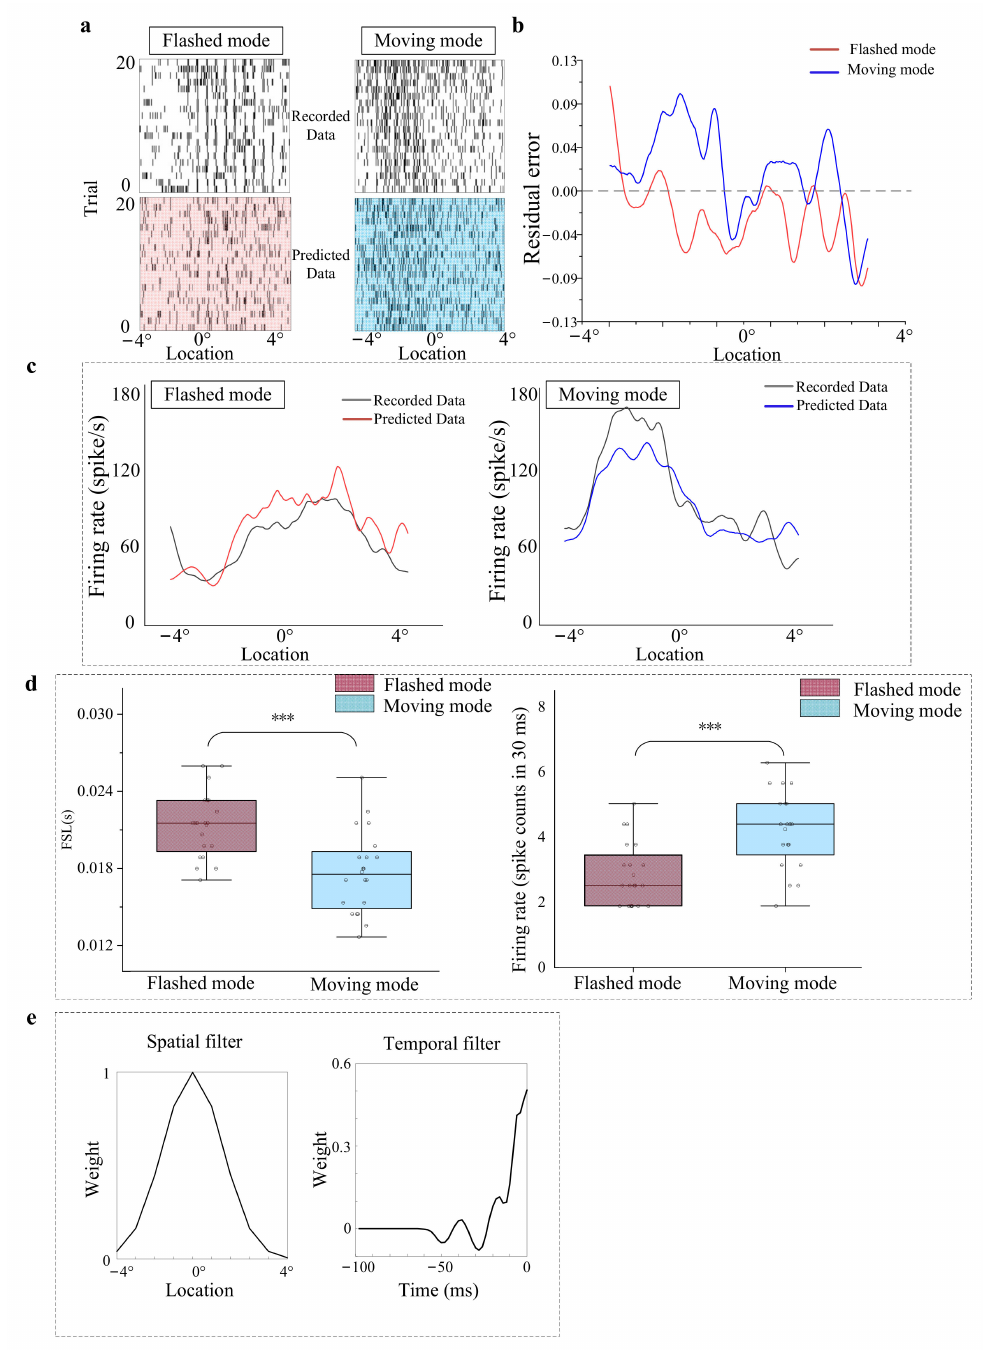
Figure 9. Simulation results of the model. ( a ) Raster plot of real neural responses and predicted neural data to the flashed stimuli (left) and moving stimuli (right). ( b ) The residual error between the recorded data and the predicted response to the flashed stimuli (red) and moving stimuli (blue). ( c ) The corresponding post-stimulus time histograms for 20 repetitions for the flashed paradigm (left) and the moving paradigm (right). The red line indicates true post-stimulus time histograms, and the gray line indicates predicted post-stimulus time histograms. ( d ) First spike latency (left) and firing rates (right) for moving and flashed stimuli generated by the model. The ‘***’ indicates a significant difference between two groups of data (Wilcoxon rank-sum test, p < 0.001). ( e ) Estimated spatial filter (left) and temporal filter (right) for the example